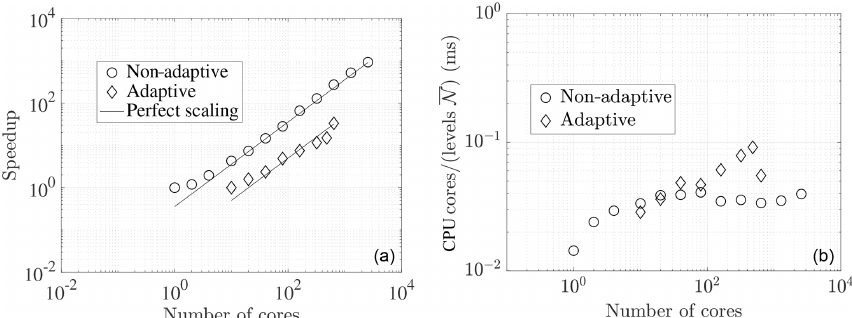
Figure 4. Strong scaling of wavetrisk on the Compute Canada machine niagara for a simulation of the Held and Suarez (1994) general circulation experiment for a perfectly balanced (non-adaptive) run at a resolution of J = 8 (1 / 4 ◦ ) and for a strongly unbalanced (dynamically adaptive) run at a maximum resolution of J = 9 (1 / 8 ◦ ) resolution with trend-based error tolerance ε = 0 . 08. (a) Speedup compared with perfect (linear) scaling. The non-adaptive case has perfect linear scaling for more than eight cores, while the adaptive case has power law scaling of approximately 0.78. (b) Absolute strong scaling performance in milliseconds (ms) (wall-clock time per time step multiplied by the number of cores, i.e. CPU hours per time step, divided by the average number of active nodes over all vertical levels and all scales). N is the average number of active nodes over all scales. Note that the absolute times shown in panel (b) are slower than equivalent times reported in Table 2 because we used a RK45ssp (with one additional trend evaluation) and code was compiled with gfortran rather than ifort for the scaling